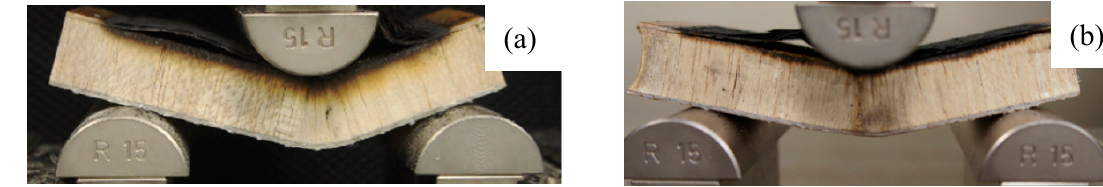
Figure 9. Post-residual flexural mechanical responses as a function of fire exposure time: normalized residual force ( a ) and normalized residual modulus ( b ).